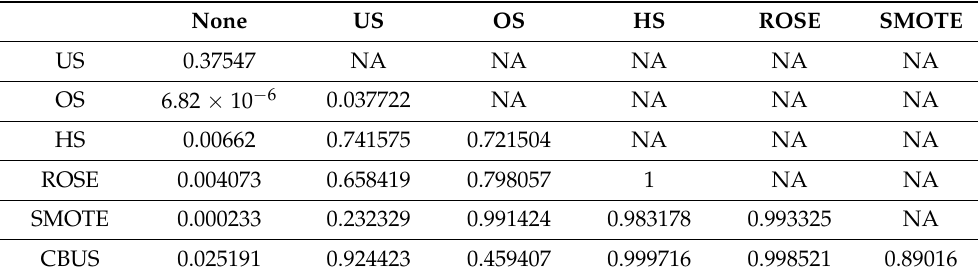
Table 9. Post hoc analysis using Nemenyi multiple comparison test for kNN.